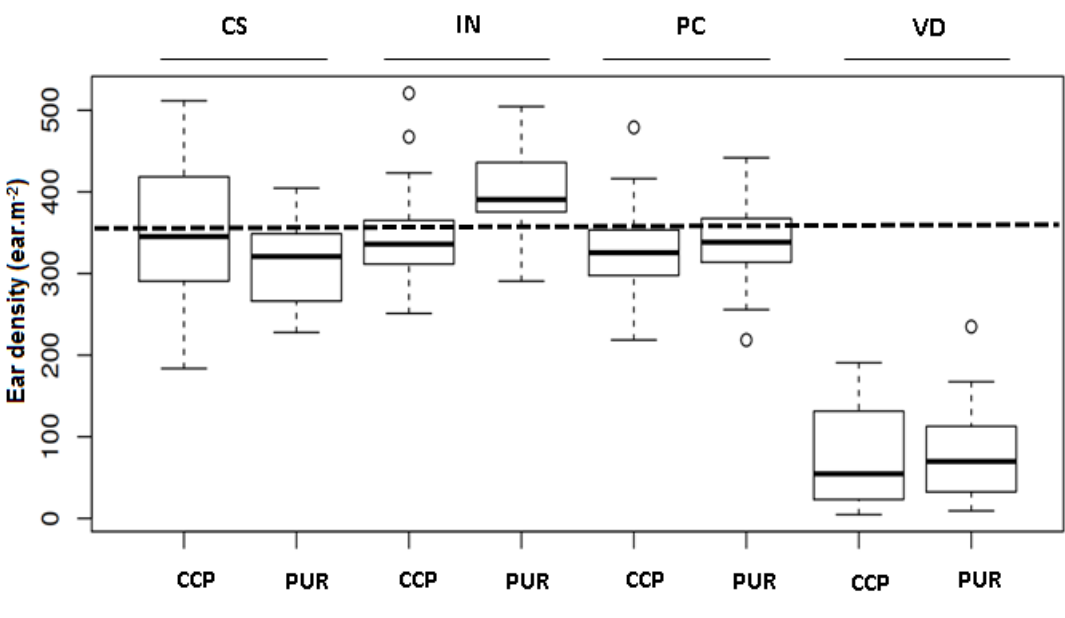
Figure 2. Box Plots of ear density (ear.m − 2 ) for each site (CS, IN, PC and VD) and variety (CCP = Composite Cross Population, PUR = Pure line). The dotted line represents the mean ear density expected for pure lines grown under organic wheat cropping conditions (CREAB